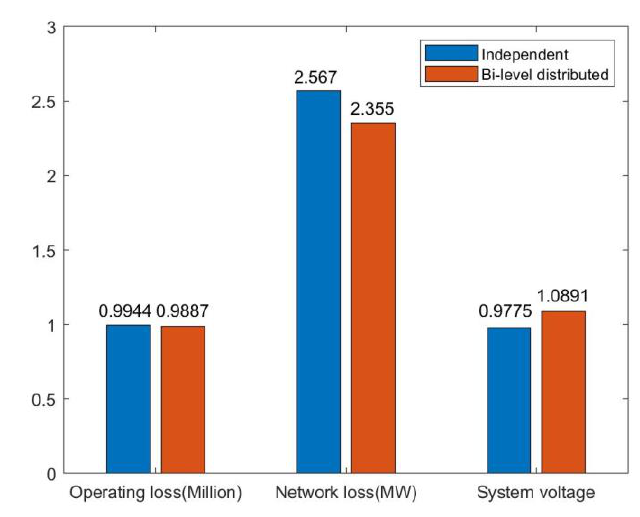
Figure 11. Result of two optimization methods of DSO2.